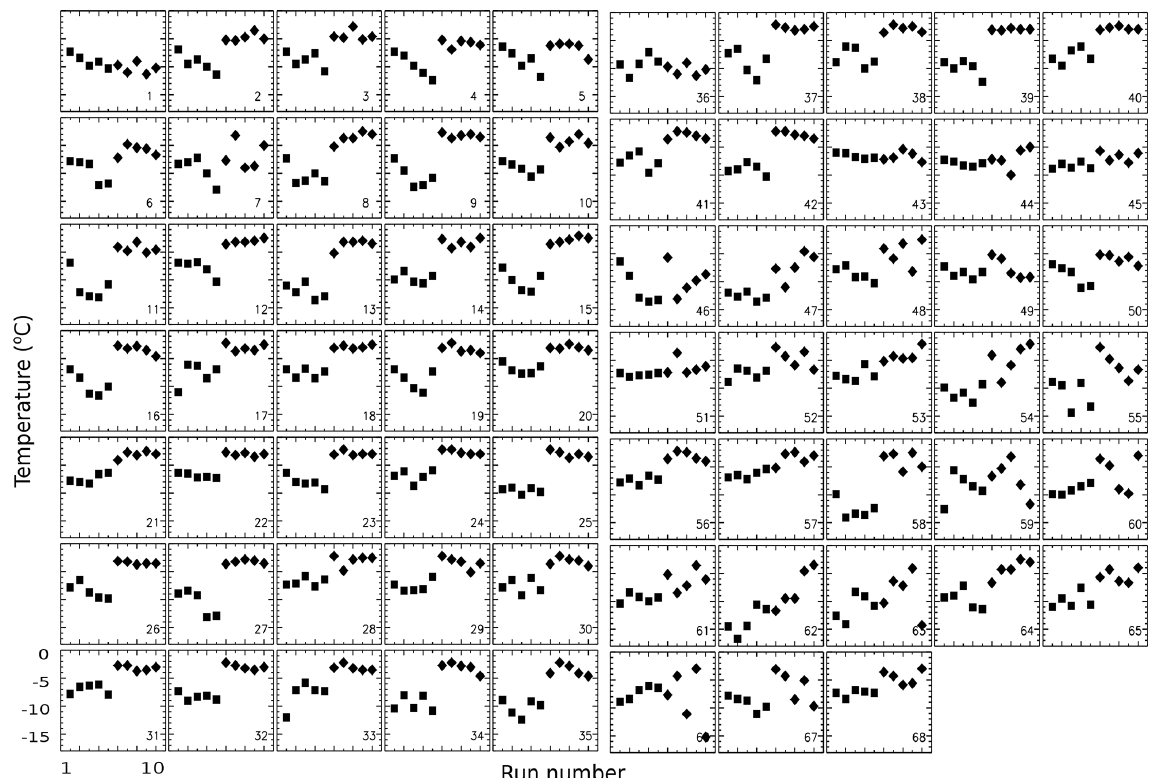
Figure 14. Freezing temperatures of 68 drops in Exp. I. The first five points (square symbols) in each panel are for runs 1 ... 5 with T w = + 10 ◦ C, and the last five points (diamond symbols) are for runs 6 ... 10 with T w = + 1 . 5 ◦